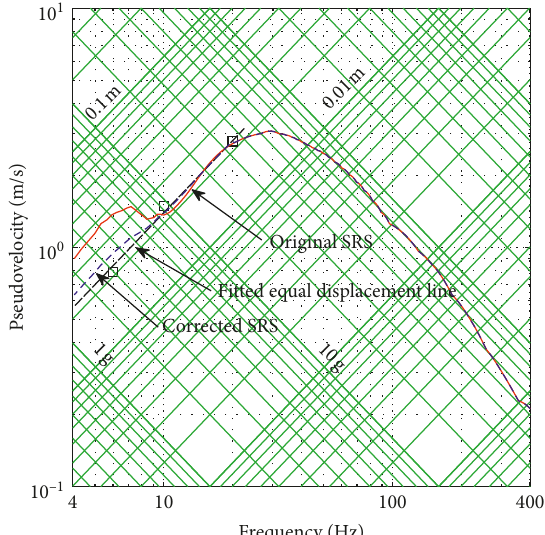
Figure 9: Comparison of the SRS before and after